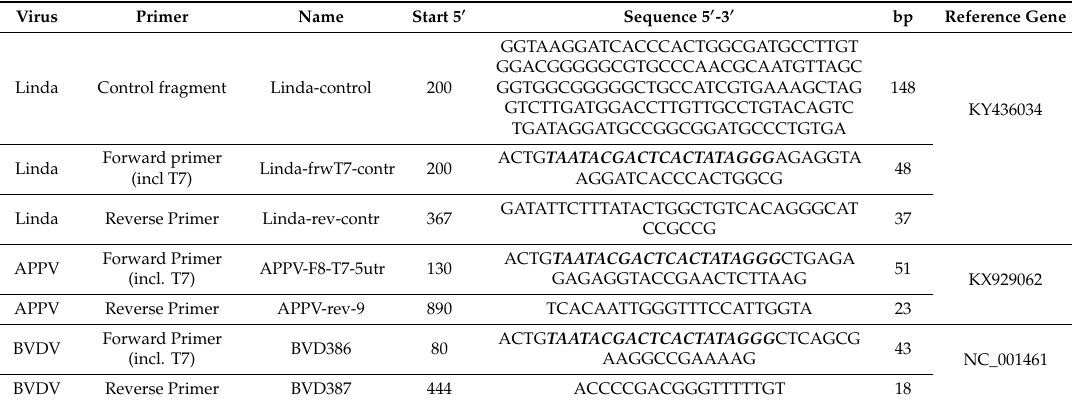
Table 2. PCR primers for the production of the control fragments ( Bold / italics = T7 promoter sequence ). Virus